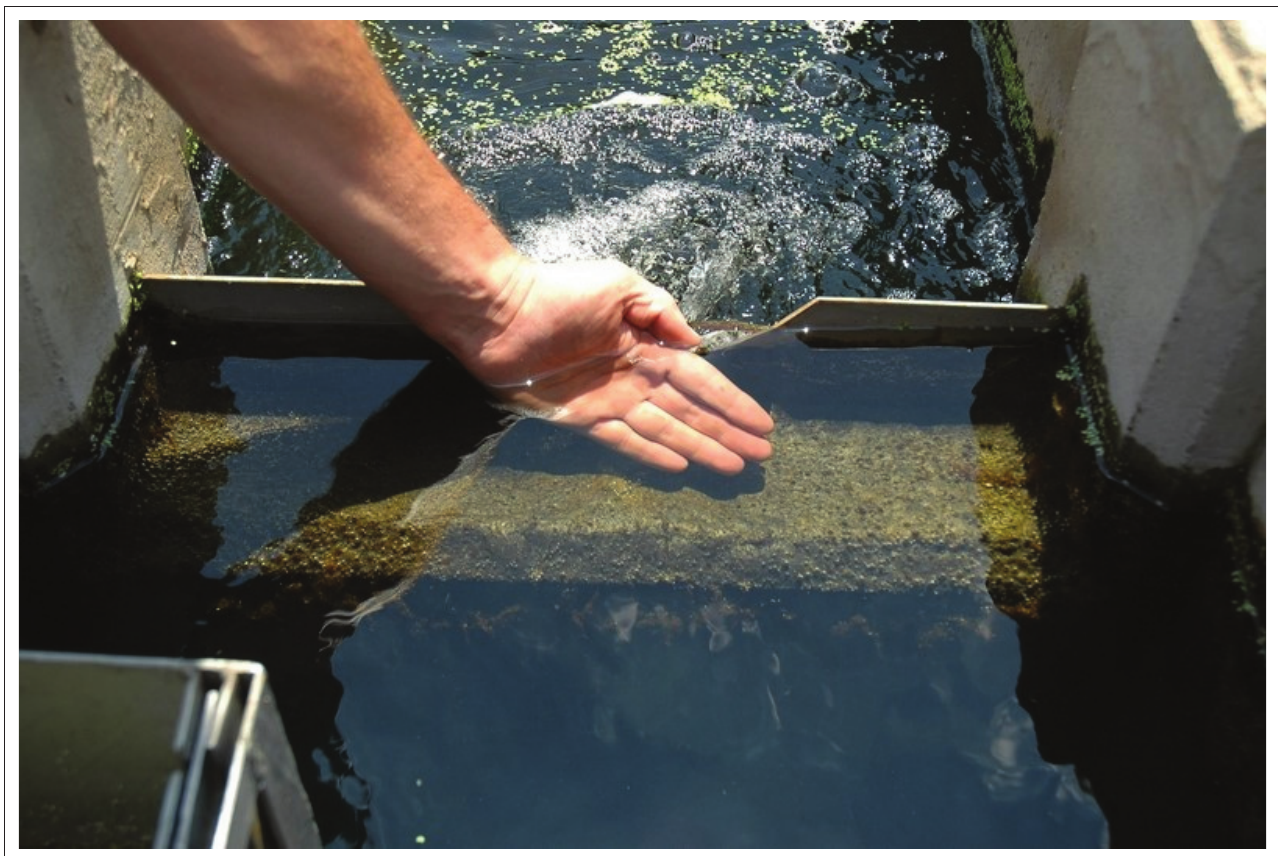
FIGURE 3: What final effluent from a wastewater treatment works should look